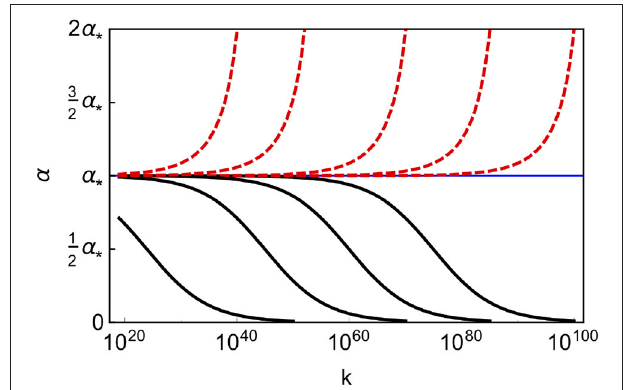
g 2 Y / (4 π ) described by FIGURE 11 | The transplanckian RG flow for α = Equation (56) features trajectories emanating from the free fixed point (black, continuous line), which approach the interacting fixed point at α * . One unique trajectories (blue, thin line) is the fixed-point trajectory for the interacting fixed point. UV unsafe trajectories are pulled toward the IR fixed point as well (red, dashed lines). Adapted from Eichhorn et al.